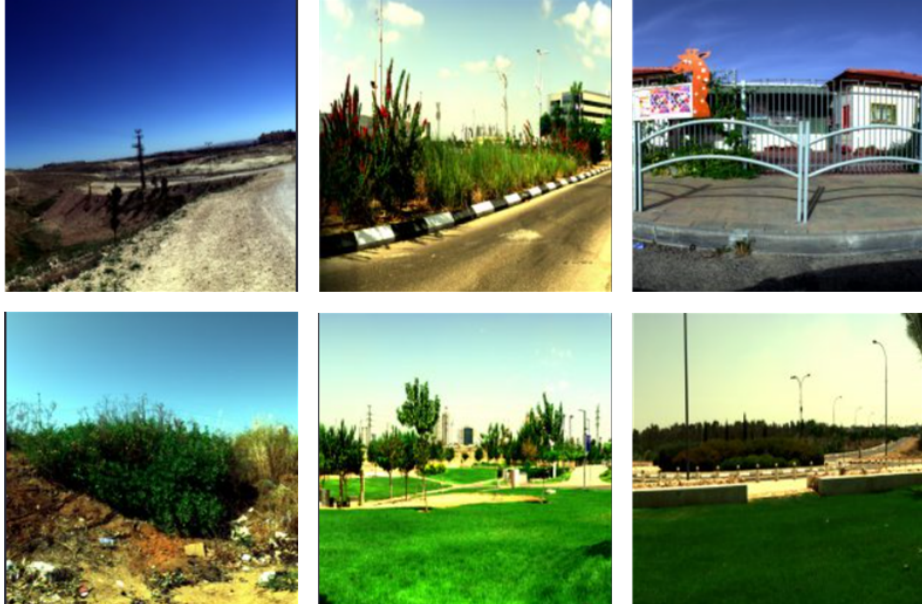
Figure 6. Presentation of the ICVL dataset. The images shown here are the RGB rendering given on the official website of thedataset